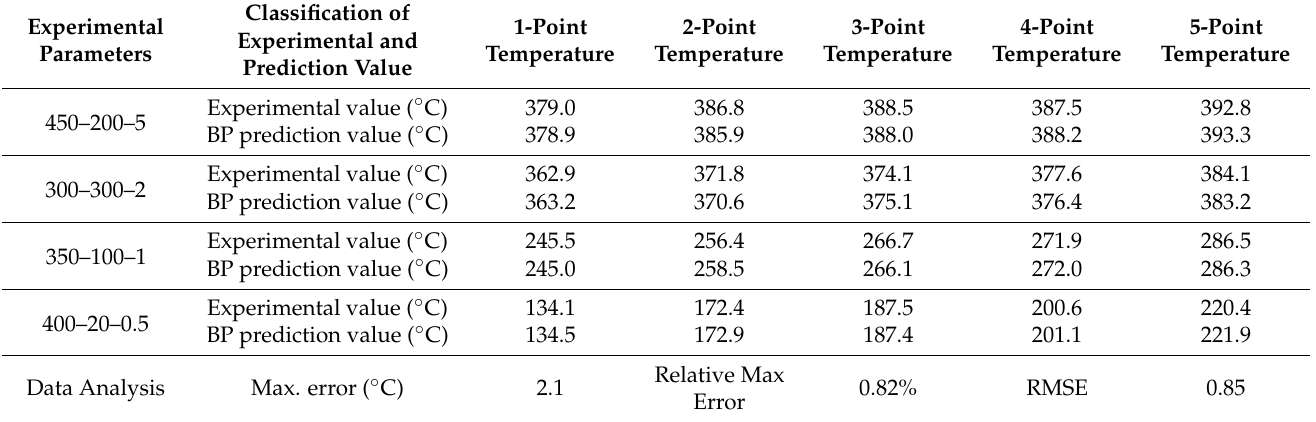
Table 6. Experimental group versus BP prediction